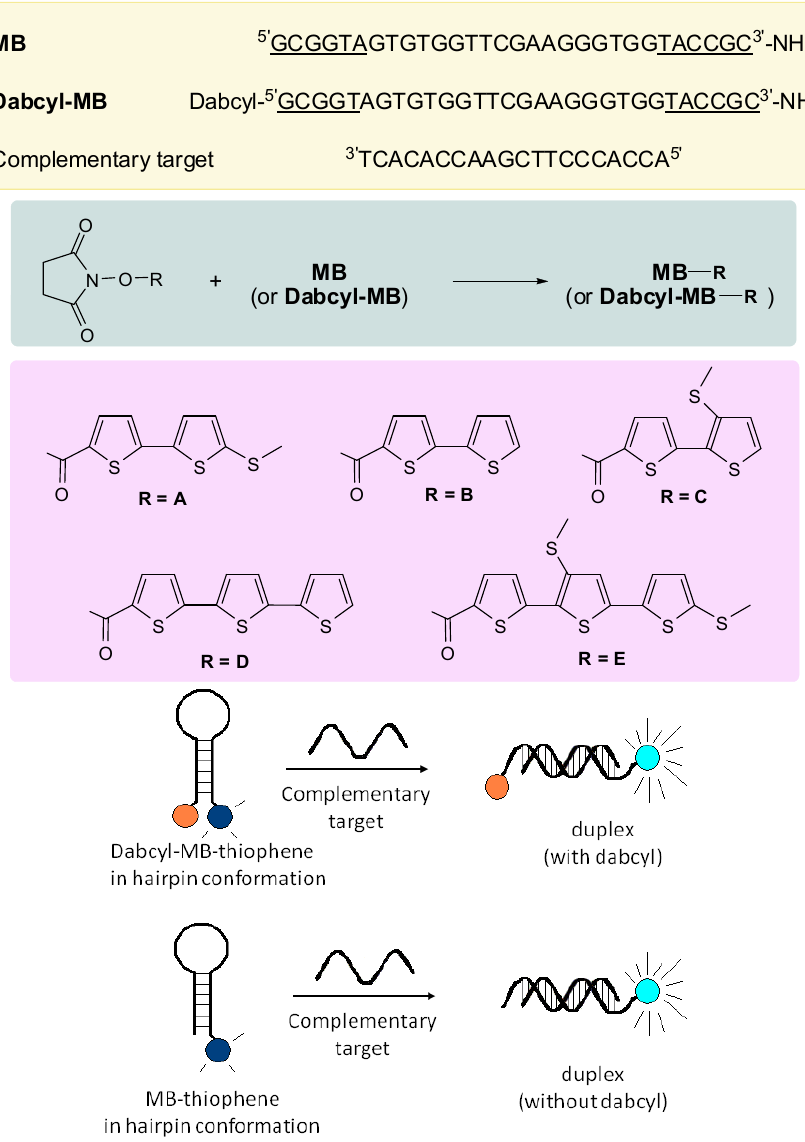
Scheme 2. Yellow panel: oligonucleotide sequences, the underlined bases form the hairpin region. Green panel: labeling reaction. Pink panel: list of fluorophores. Cartoon: schematic representation of the hybridization of the molecular beacon (MB) with its complementary target, to give a duplex with or without the dabcyl quencher (orange circle). In successfully experiments, the emission of the fluorophore (blue circles) increases (cyan circles) passing from the hairpin configuration to the extended duplex